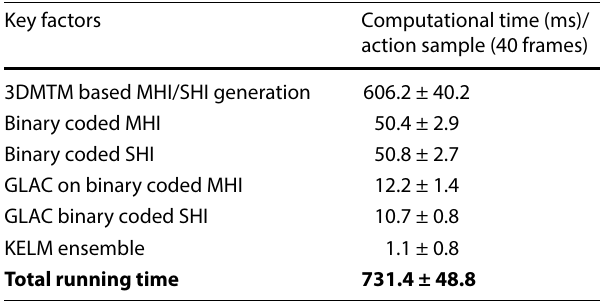
Table 7 Computational time (mean ± std) of the key factors of the